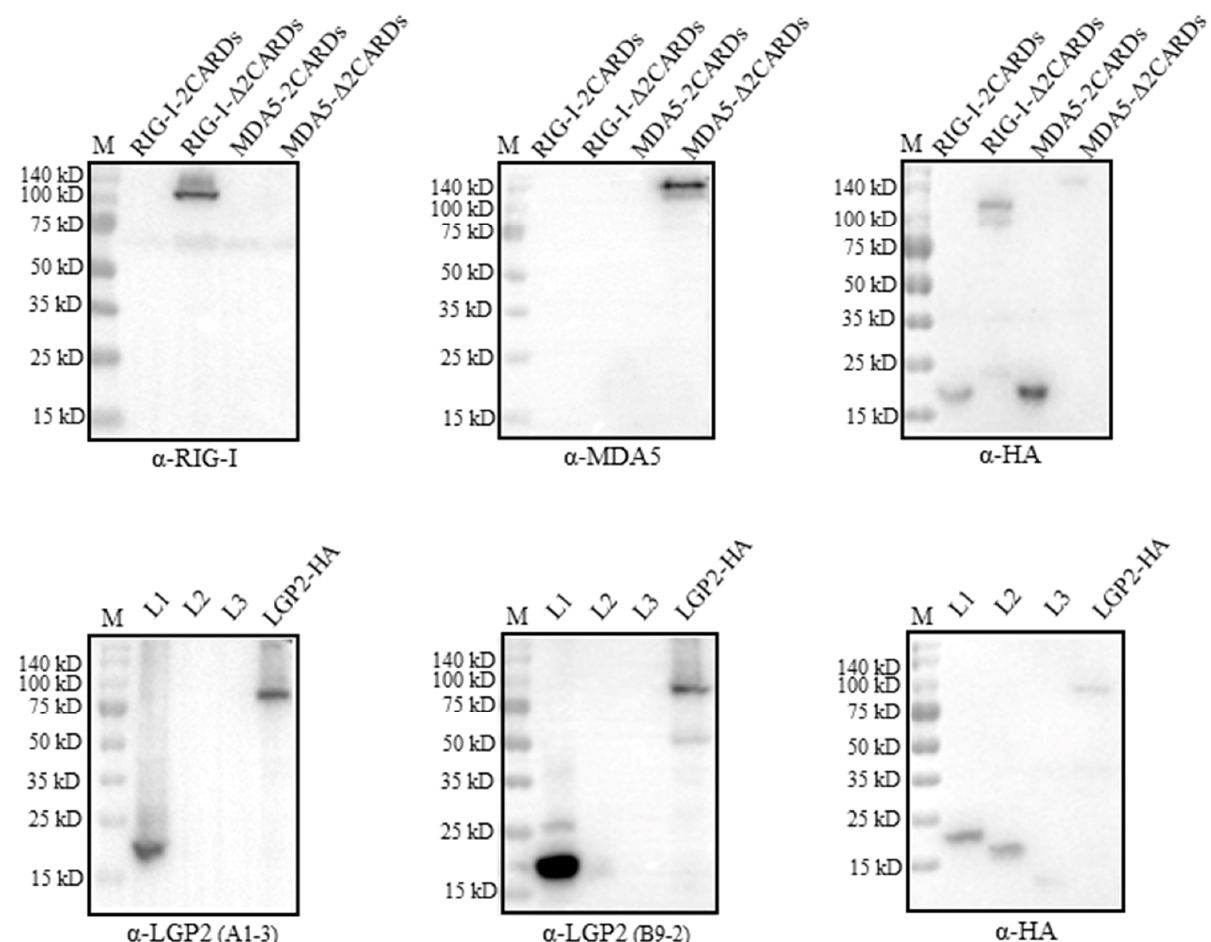
Figure 4. The identification of regions on three porcine RLR proteins recognized by four RLR mAbs. We transfected 293T cells (2 × 10 5 cells/well) in 24-well cell culture plates with HA-tagged expres- sion plasmids for pRIG-I-CARDs, pRIG-I- ∆ CARDs, pMDA5-CARDs, pMDA5- ∆ CARDs, pLGP2-L1, pLGP2-L2 and pLGP2-L3 (0.5 µ g each) for 48 h, and the harvested cell lysates were subjected to Western blotting with HA mAb and the indicated porcine RLR ascite mAbs. The protein markers are labeled on the